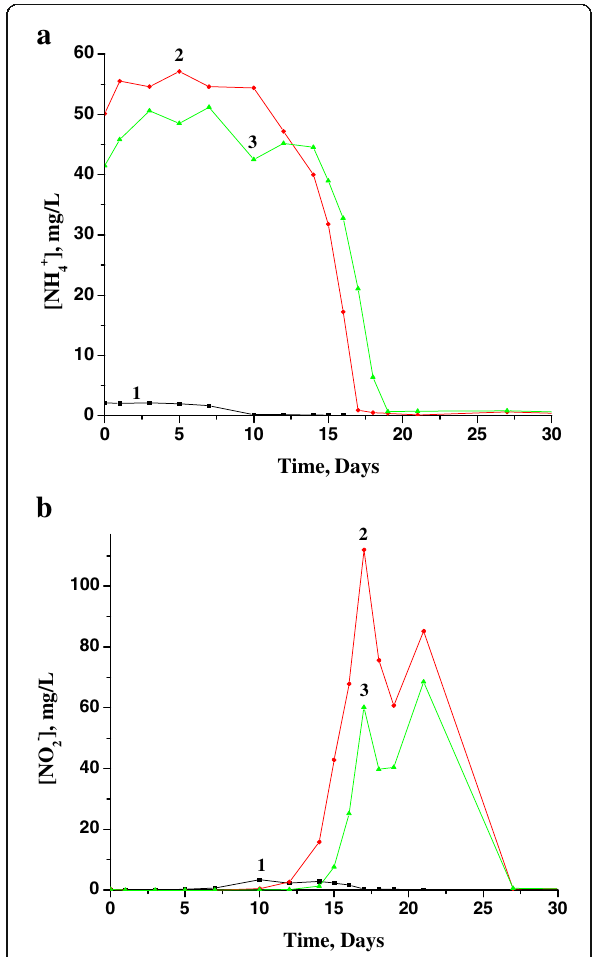
Fig. 6 Dynamics of ammonium ( a ) and nitrate ( b ) ion concentrations in the Bic and Nistru Rivers in natural samples. 1 — Nistru River upstream Bic River. 2 — Bic River watering place in Nistru River. 3 — Nistru